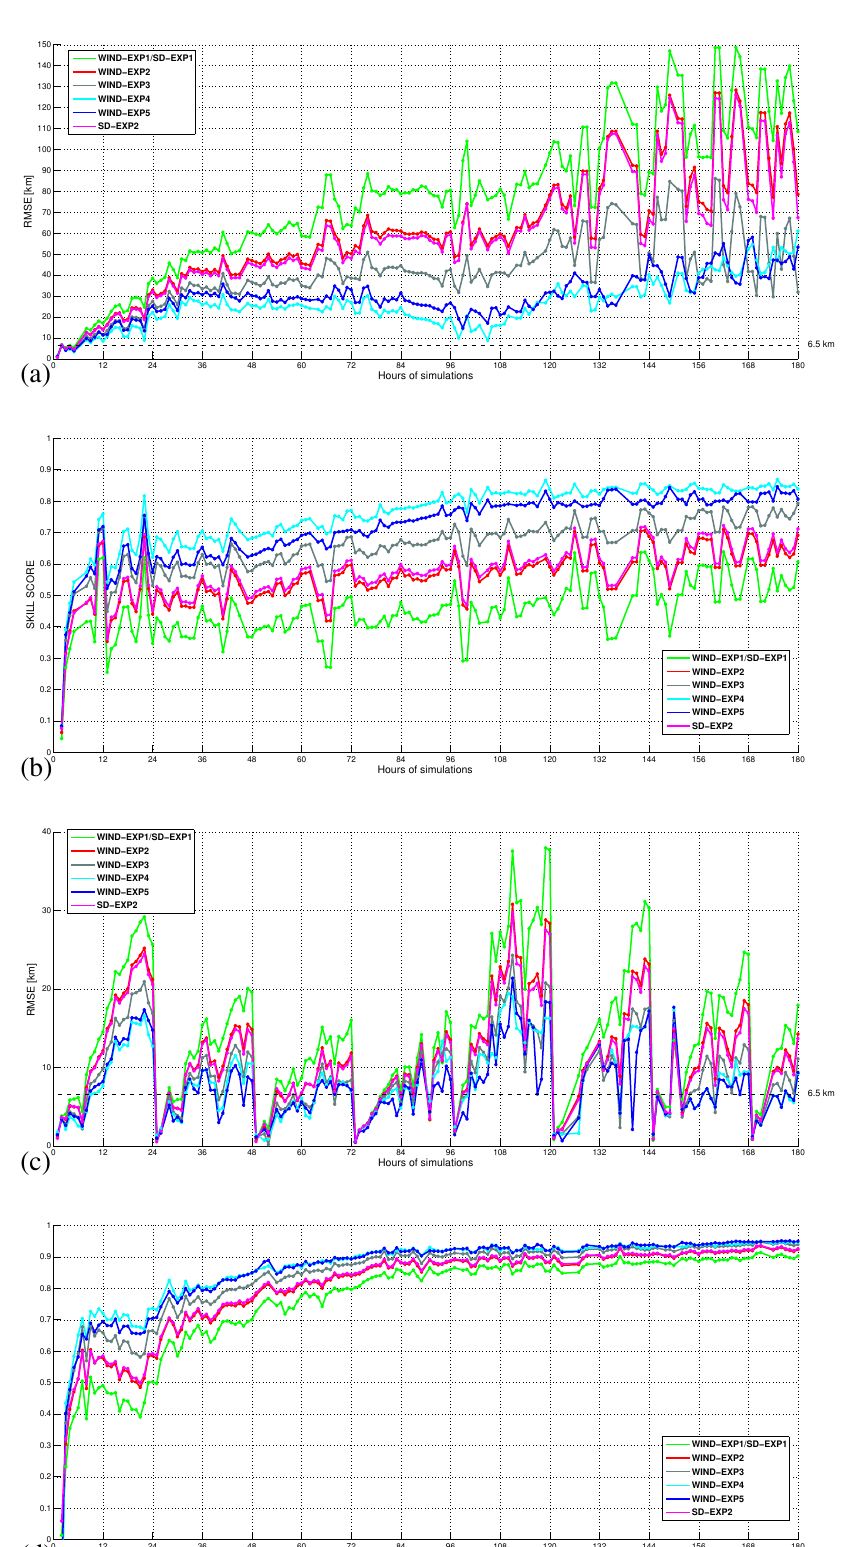
Fig. 6. RMSE and skill score between the observed and simulated trajectories of Fig. 4 (panels (a) and (b) ) and Fig. 5 and (panels (c) and (d) ) as a function of the prediction time (from 14th October 2007 to 22th October 2007).